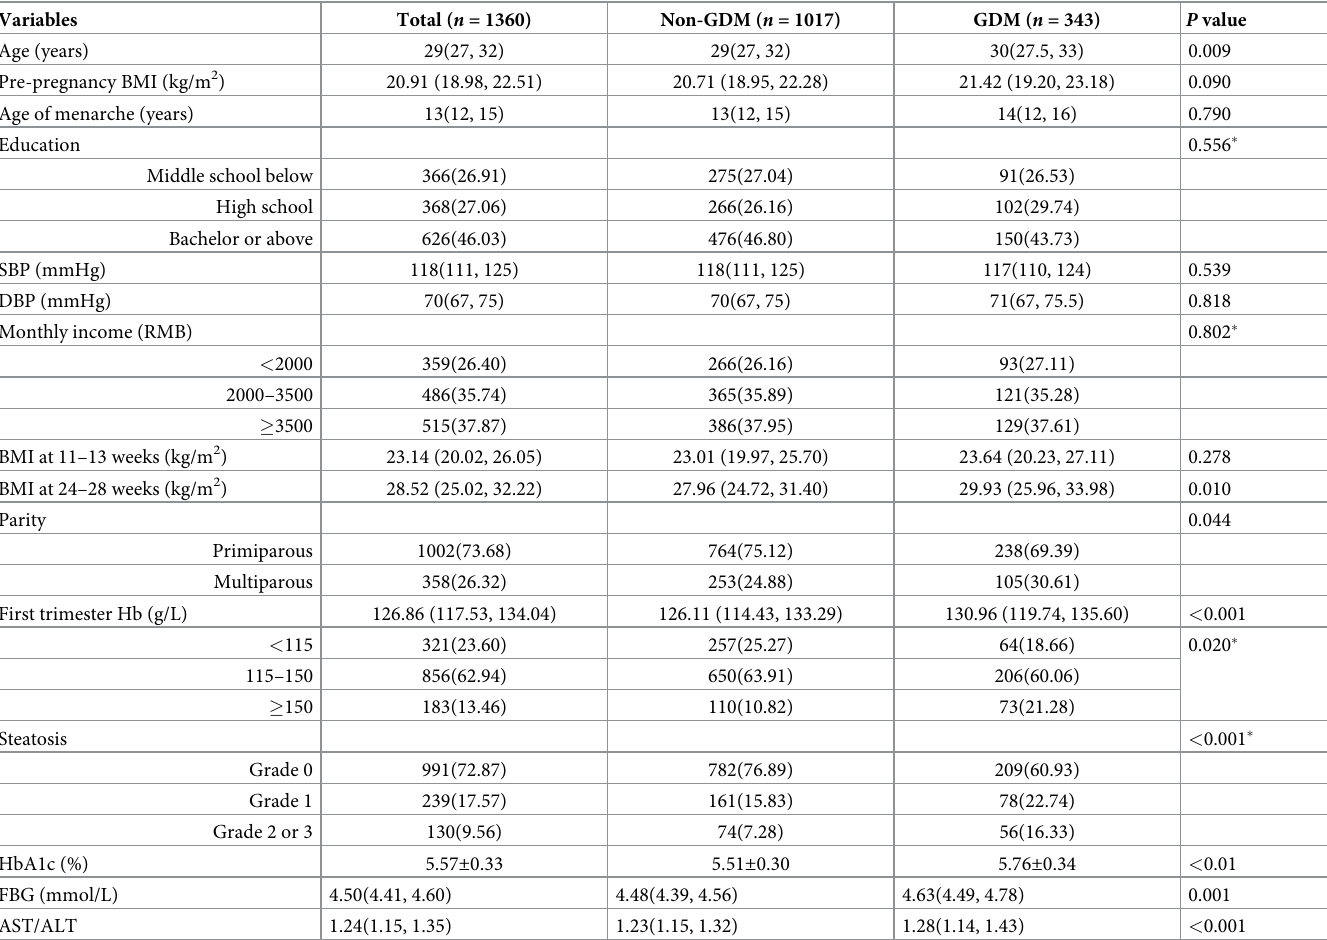
Table 1. The demographic and clinical characteristics of pregnancy woman in this